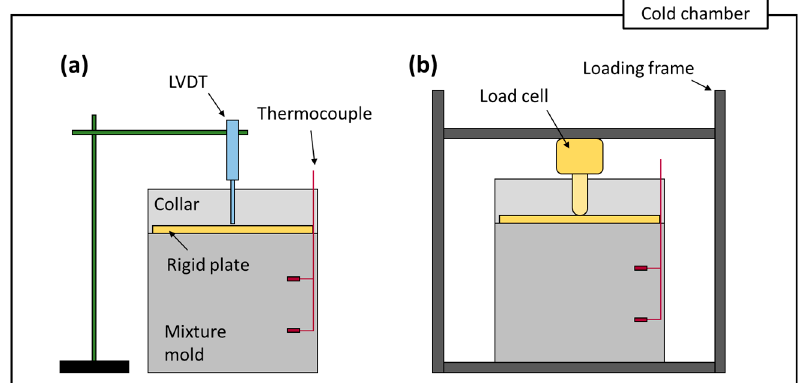
Figure 4. Scheme of frost experiments. Setup for ( a ) frost heaving test and ( b ) frost heaving pressure test.